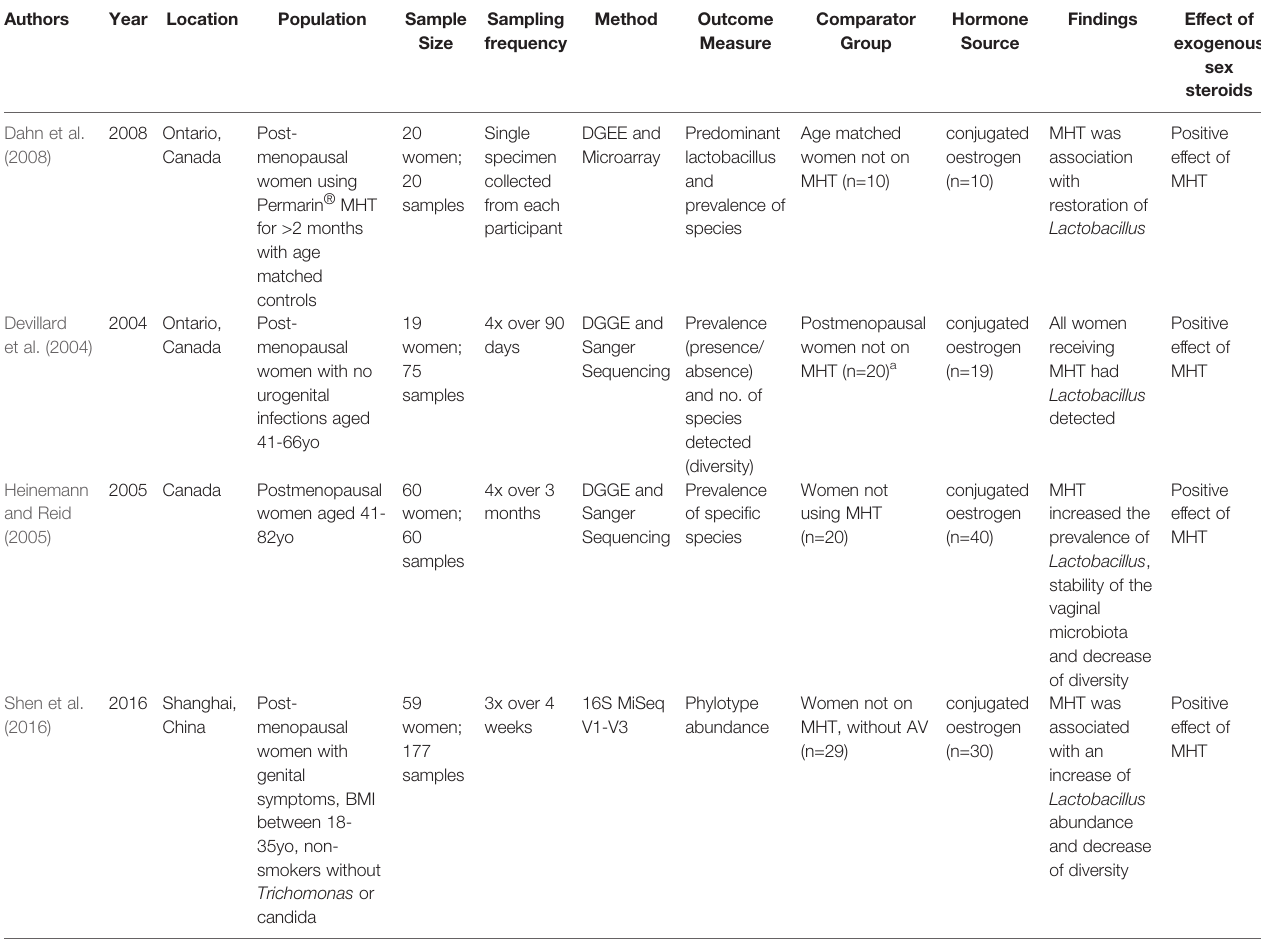
TABLE 2 | Summary of included menopausal hormone therapy